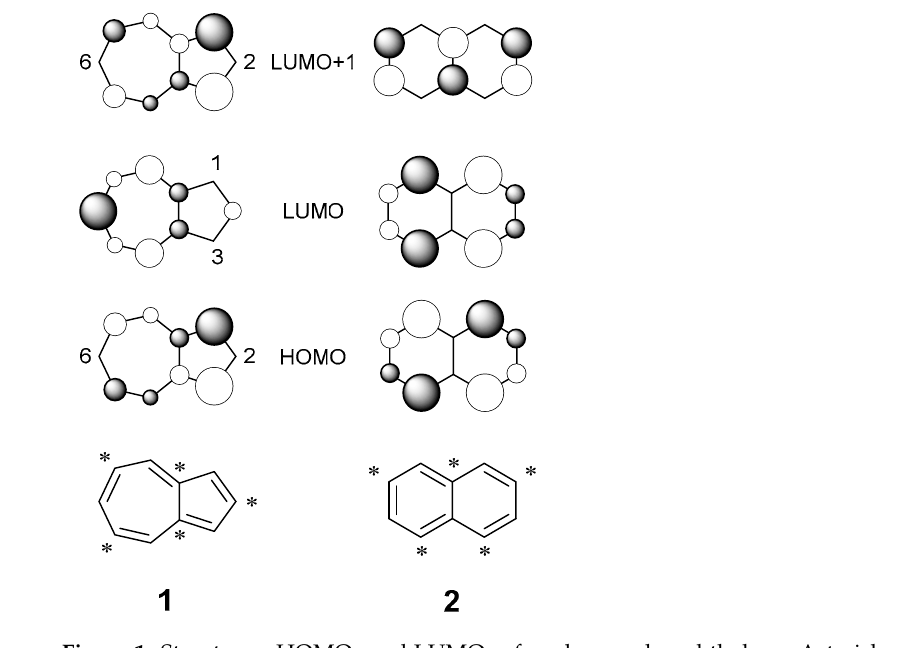
Figure 1. Structures, HOMOs and LUMOs of azulene and naphthalene. Asterisks (*) are used to show the alternant nature of naphthalene and the non-alternant nature of azulene.